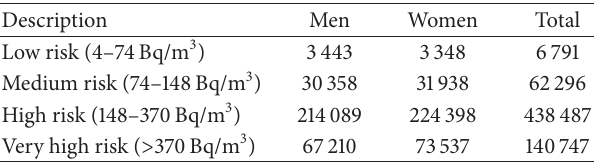
Table 5: Radon exposure risk categories (Bq/m 3 ) versus AGEB (total